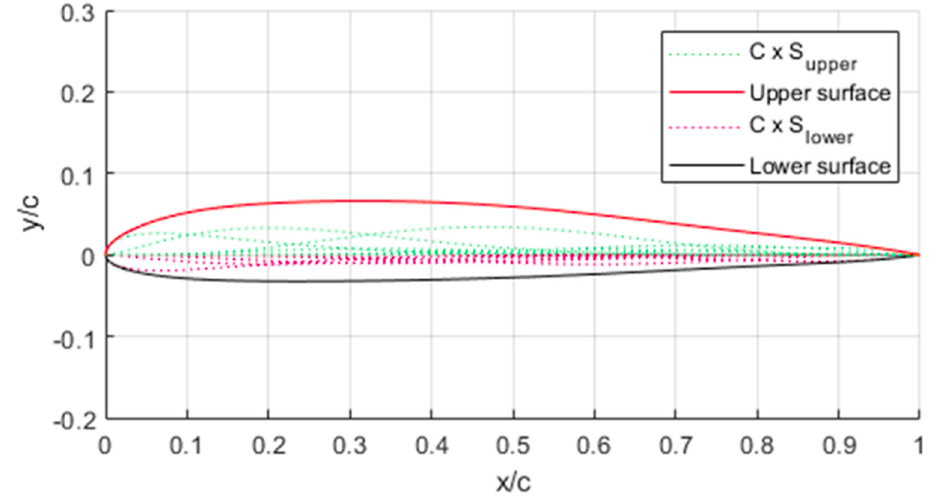
Figure 5. Airfoil shape obtained from the product of class and shape function C ( x ) and S ( x ).